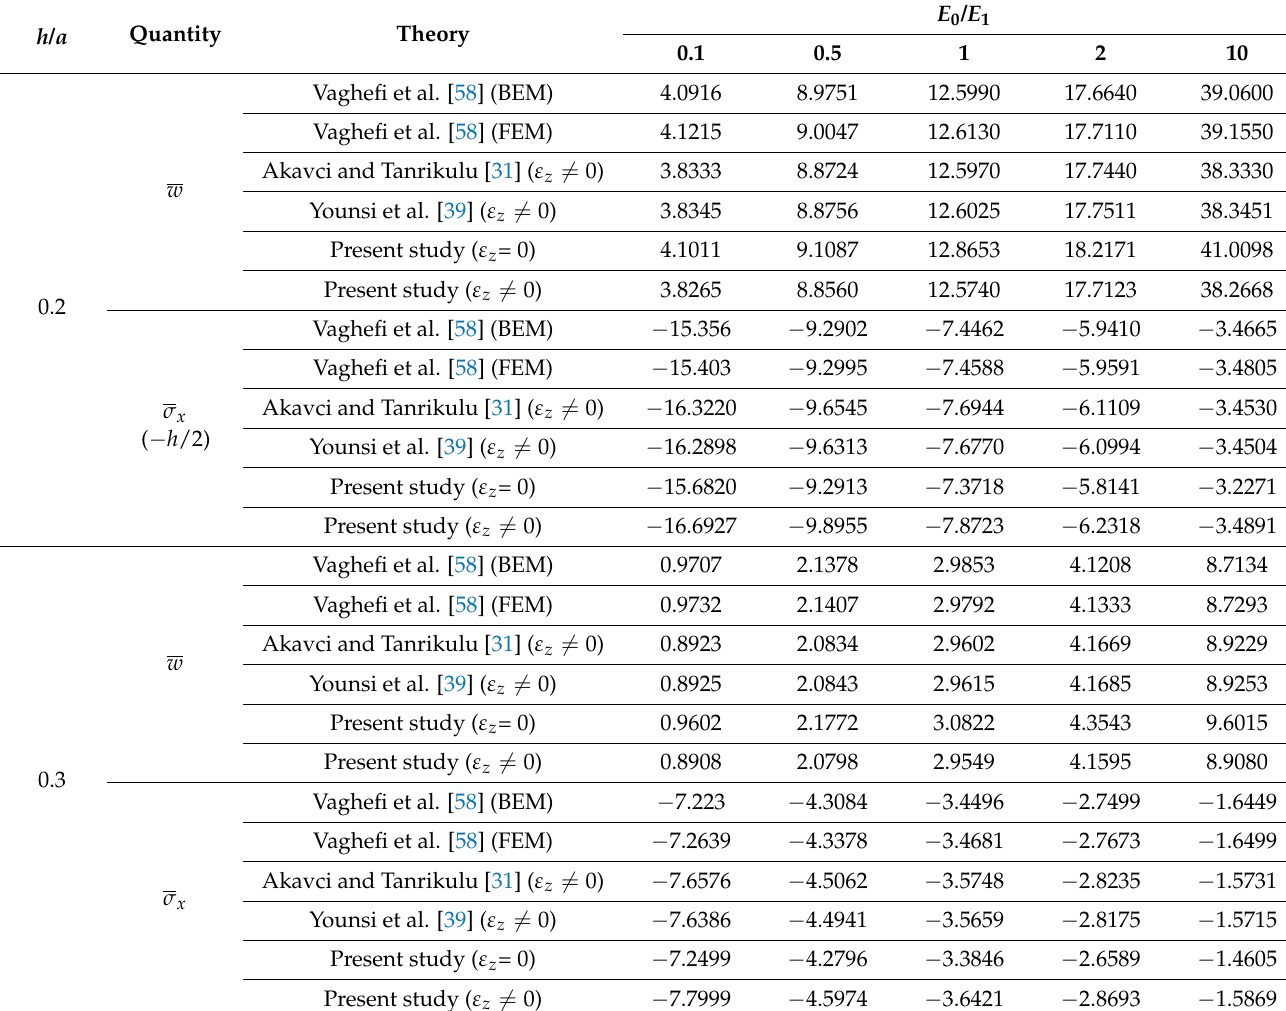
Table 7. Non-dimensional central displacement w ( 0 ) = G ( h ) w / h q 0 and in-plane normal